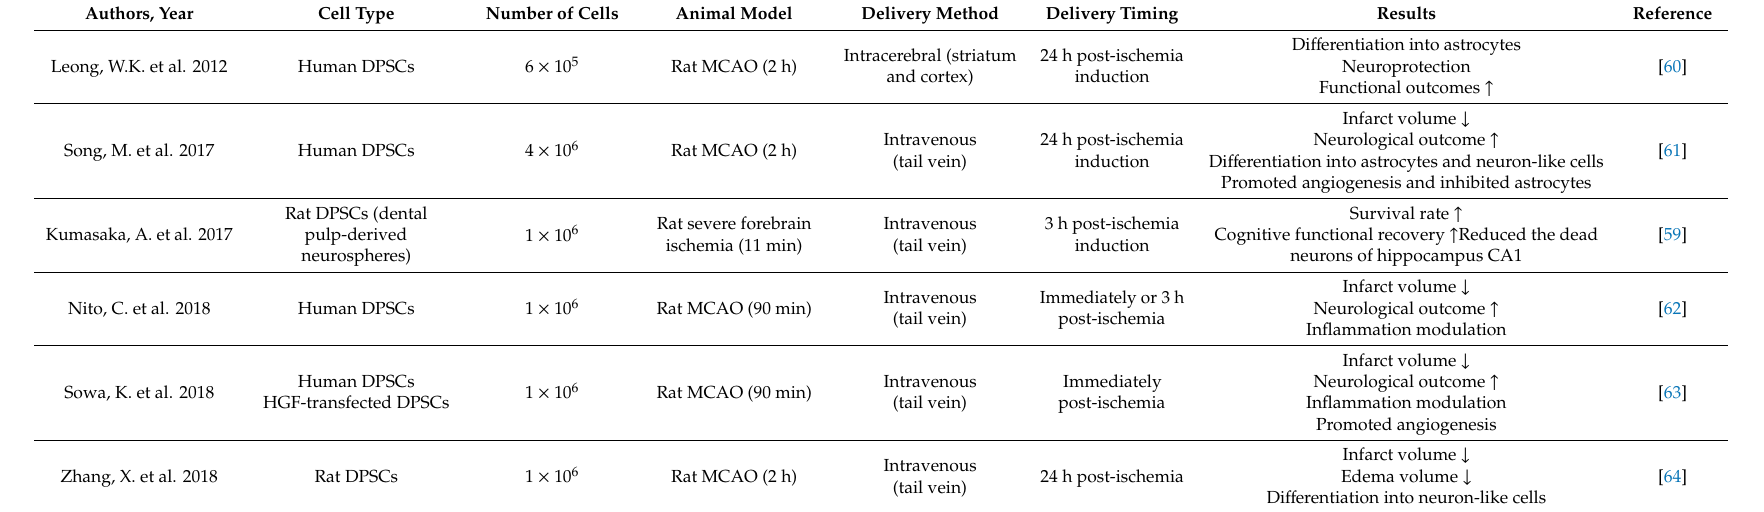
Table 3. Experimental study for the dental pulp stem cells (DPSCs) transplantation into ischemic brain injury in animal